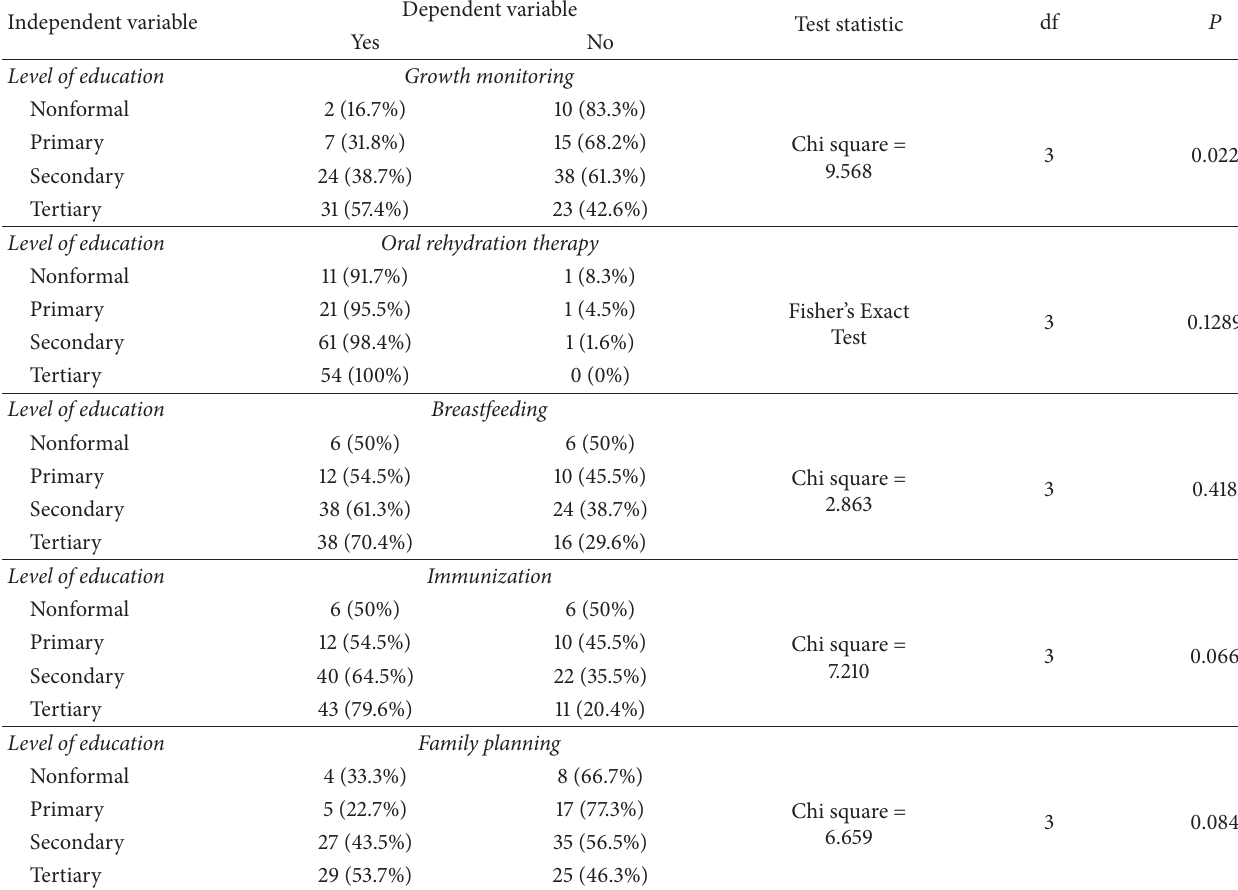
Table 6: Association between level of education and knowledge of child survival